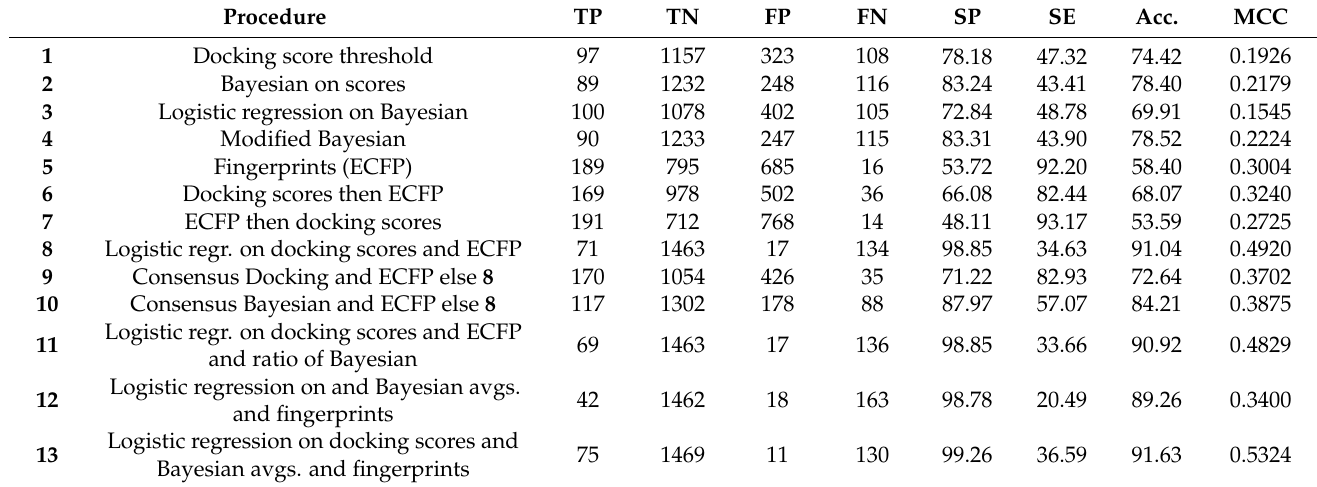
Table 1. True positives (TP), true negatives (TN), false positives (FP), false negatives (FN), specificity (SP, %), sensitivity (SE, %), accuracy (Acc., %), and Matthews correlation coefficient (MCC) for 13 different procedures for the training